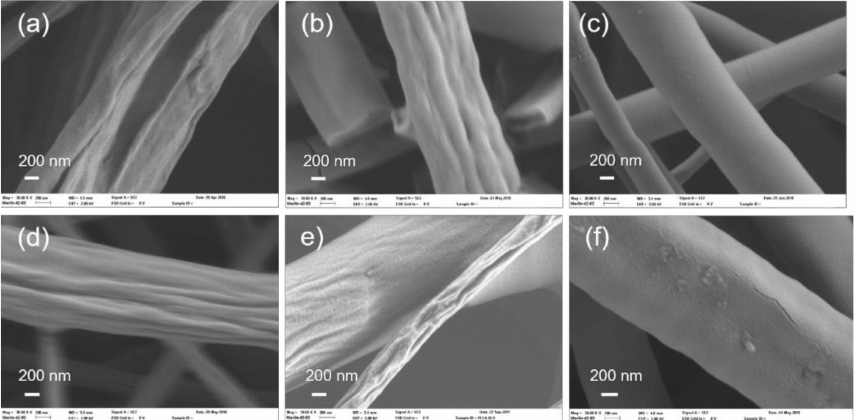
Figure 3. SEM micrographs of PLLA fibres ( a ) before ALD, or ( b ) with 2 nm Al 2 O 3 , ( c ) 30 nm Al 2 O 3 ,